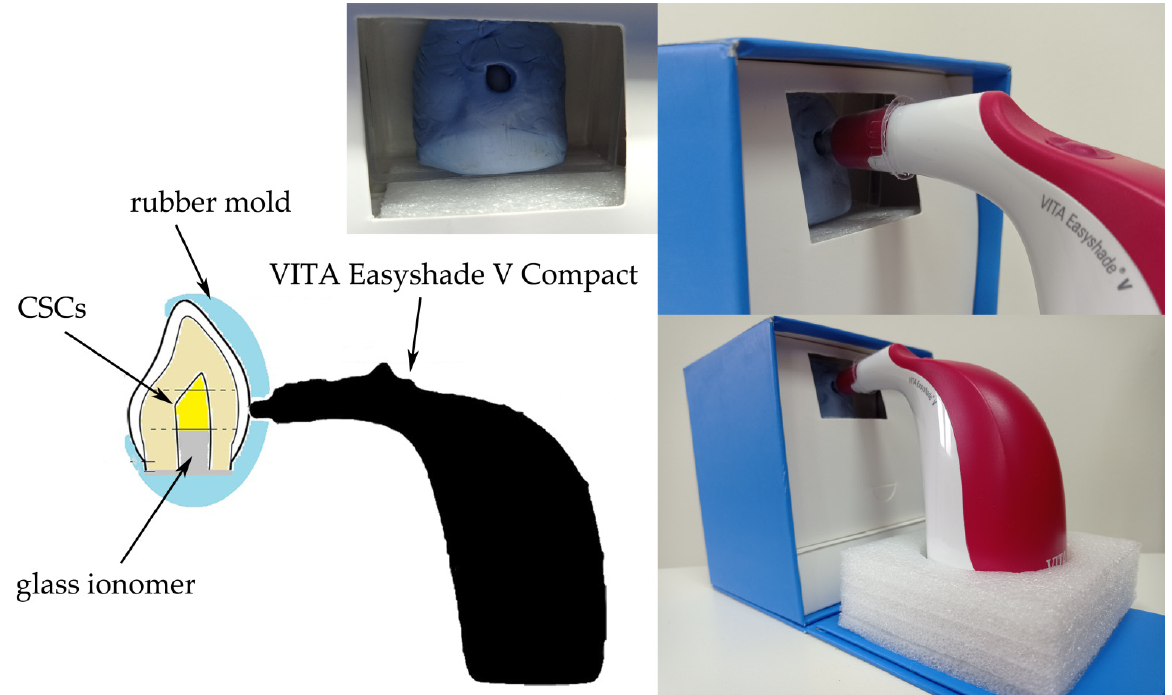
Figure 2. A schematic representation of the setup for colour measurement. All teeth were dried with a blower for 3 s before measurement. This prevented light refraction and erroneous readings. We calibrated the device before each measurement and repeated the readings thrice. Instrument was placed in the calibration holder so that the probe tip was flush and perpendicular to the calibration block and depressed the calibration switch. The change in tooth colour was measured before the material placement (t0), after 1 week (t1), 1 month (t2), 3 months (t3), and 6 months (t4). Moreover, we compared the differences in the colouration under the influence of the materials with the ∆ E values in the CIE Lab colour space using visual spectrophotometry. Each colour is mathematically described by the following three components: L, or lightness, which ranges from 0 (black) to 100 (white); a, or colour ranging from green to red; and b, or colour ranging from blue to yellow. ∆ E values represent the difference between the final and baseline values. ∆ E was calculated by the following equation: [29]